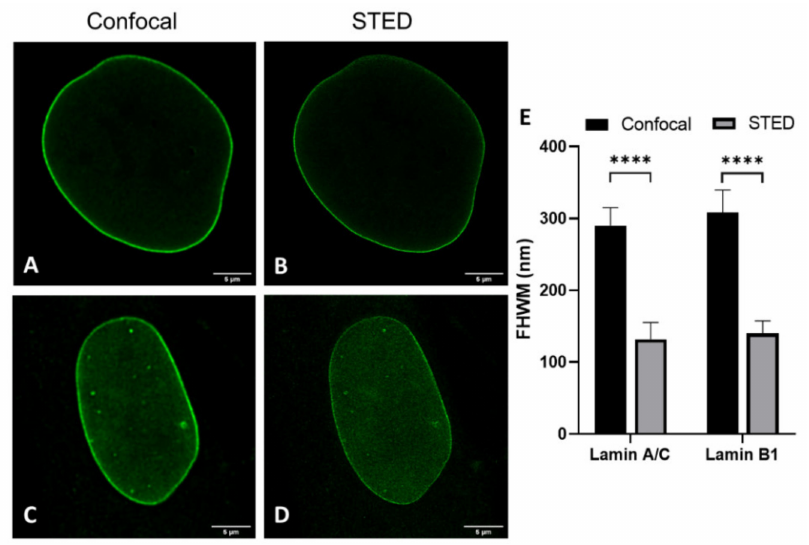
Figure 4. Comparison of confocal ( A , C ) and STED ( B , D ) microscopy images. ( A , B ) nHDF stained with antibodies against lamin A/C. ( C , D ) nHDF stained with antibodies against lamin B1. Scale bars: 5 µ m. ( E ) Average FWHM (nm) of confocal and STED images of antibody-stained nHDF. Bars, mean ± SD. **** p ≤ 0.0001. Lastly, the lamin layer thickness of lamin A(/C) and B1 in cells co-labeled with lamin A(/C) and lamin B1 was determined and revealed similar values in the layer thickness of lamin A and B1 with confocal and STED microscopy, independent of either the choice for transfection or antibody staining, or cell type (Figure 5, Table 1).